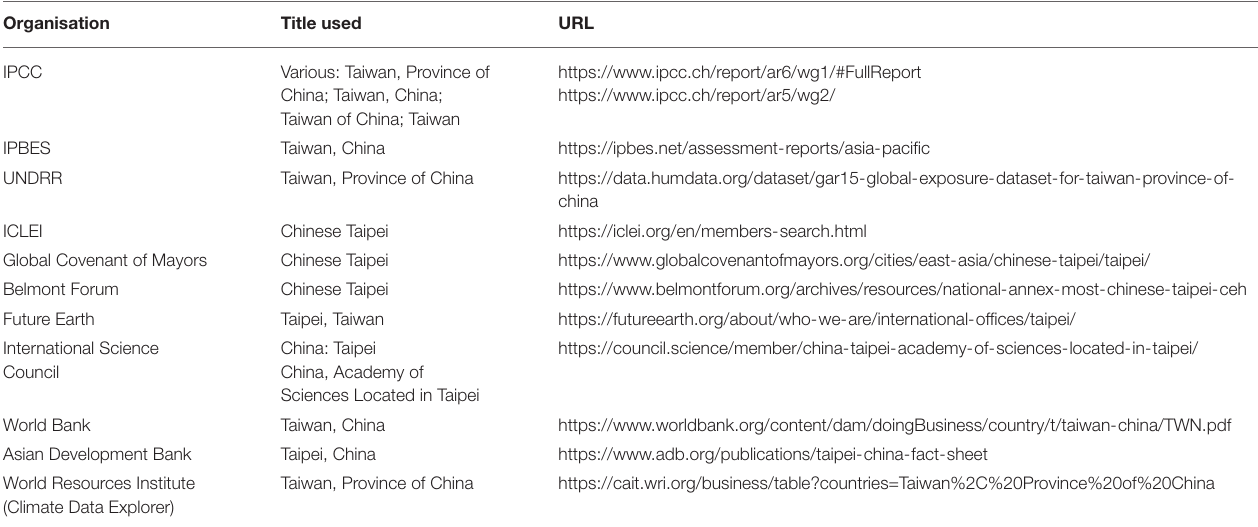
TABLE 1 | Titles used to identify Taiwan by a selection of international organisations involved in climate-related issues.